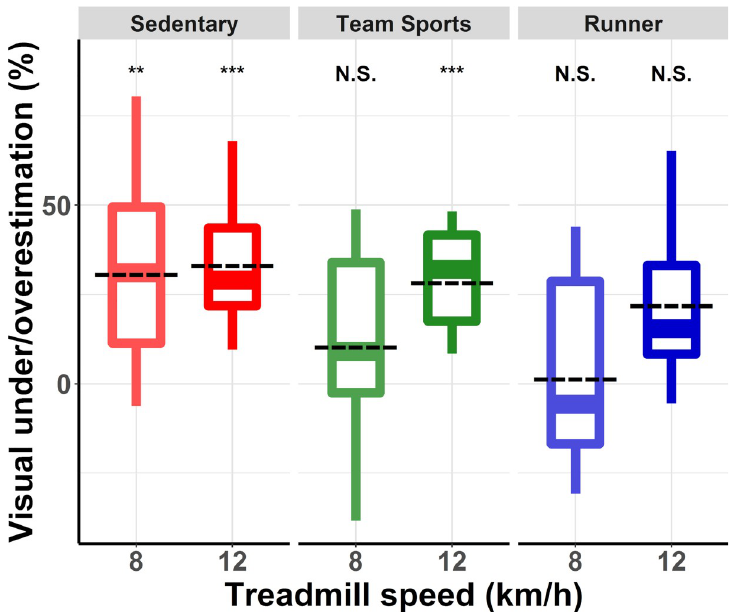
Fig 2. Percentage of underestimation (positive values) and overestimation (negative values) of visual speed relative to running speed. Estimations were computed using the equation: ln(perceived visual speed / actual treadmill speed) � 100 . Each box summarizes the distribution of responses of the participants in each group and for each treadmill speed. The central line corresponds to the median, the box defines the inter-quartile range (IQR, between first and third quartile), and the whiskers correspond to ± 1.5 IQR. Significant difference: N.S. = Not Significant, � = p < 0.05, �� = p < 0.01, ��� = p <